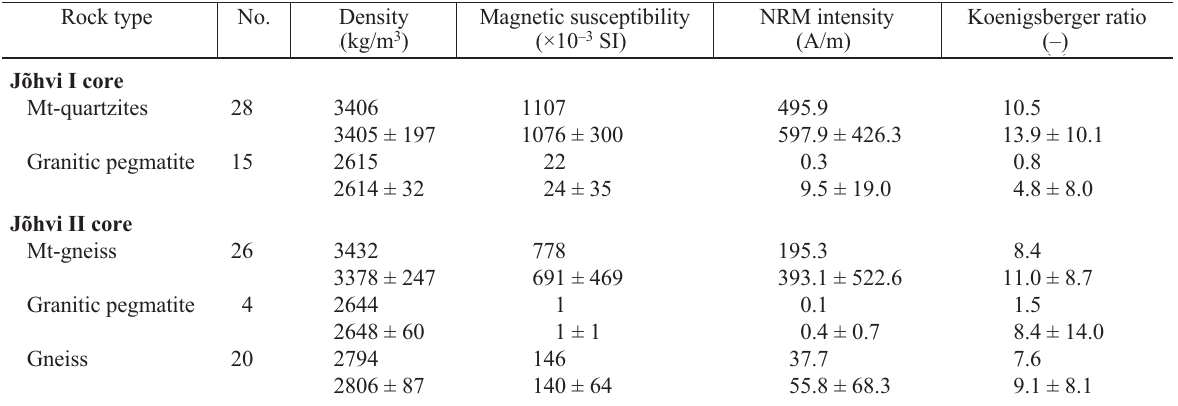
Table 1. Petrophysical properties (median, average and standard deviation) of Jõhvi core samples